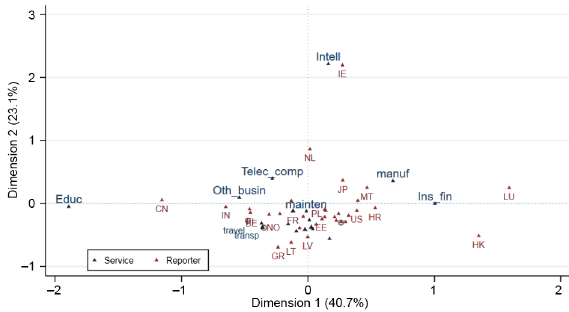
Figure 5. Service imports by service type and by country, 2017 (source: WTO mode of supply dataset, authors’ elaborations (Kerner))